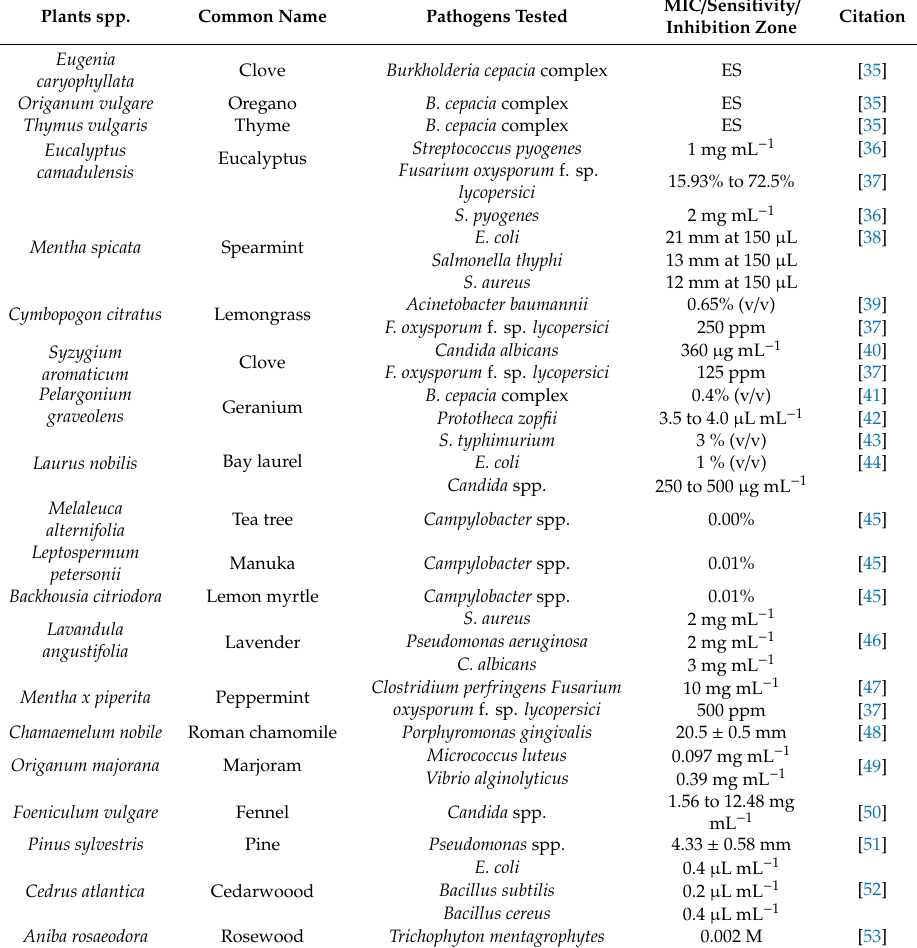
Table 1. Essential oils extracted from plant against tested pathogens. Plants